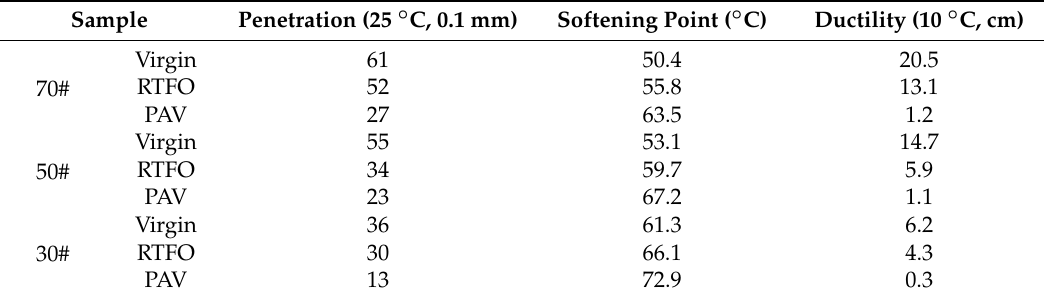
Table 1. Physical properties of bitumen before and after